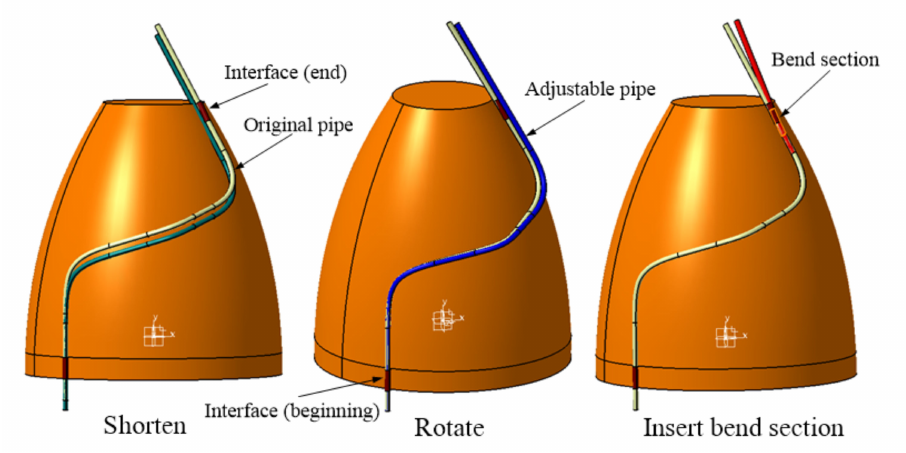
Figure 2. General approaches for adjustable